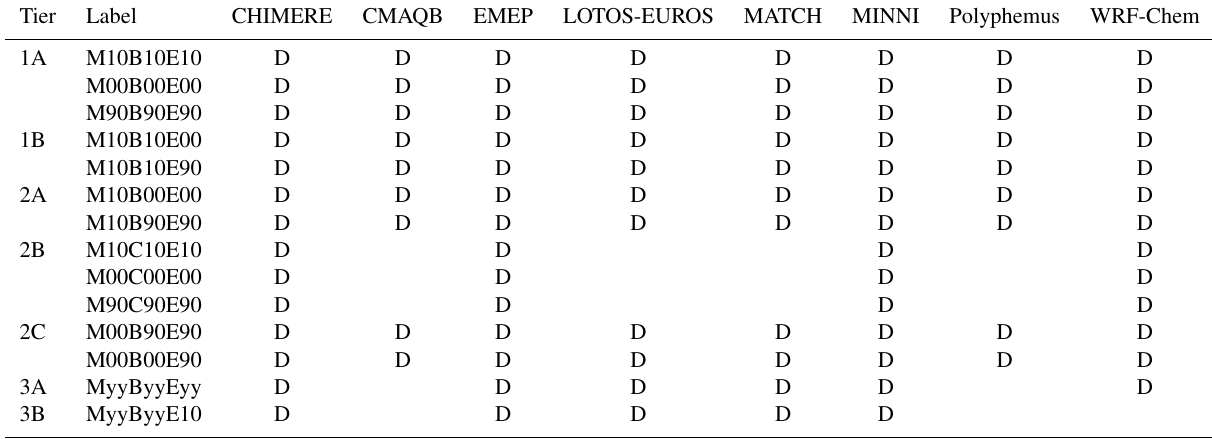
Table 3. Synthesis of models having delivered (D) data to the project database for each of the experiments.